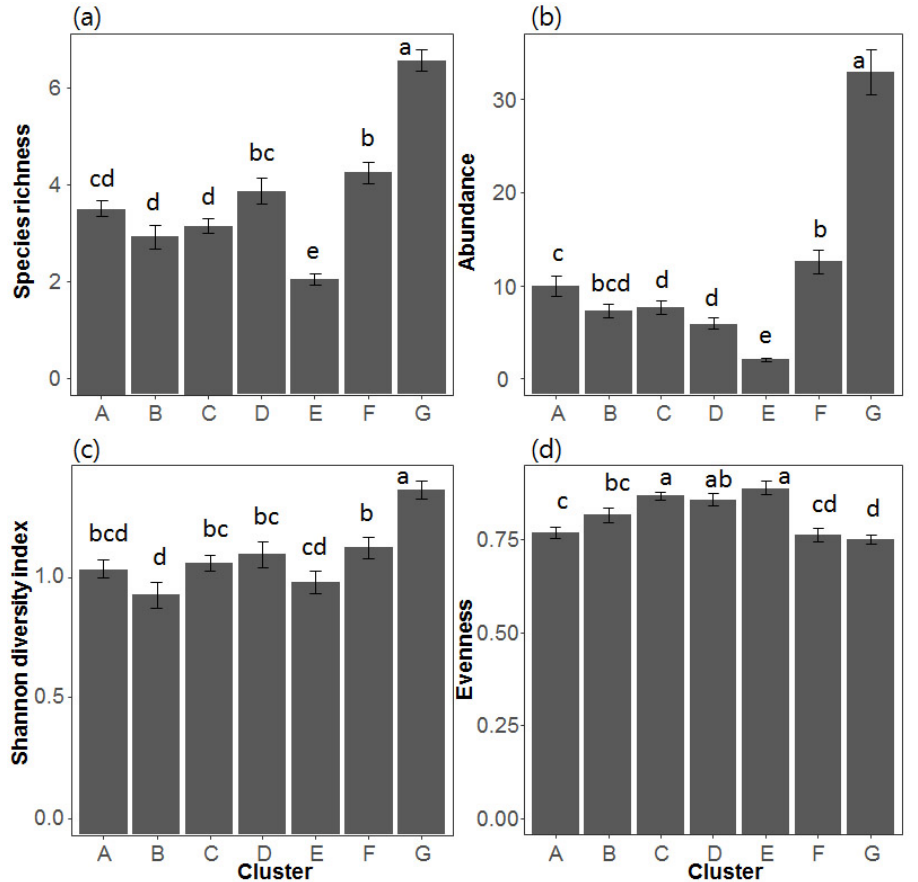
Figure 4. Differences in community indices: ( a ) species richness (number of species); ( b ) abundance (number of individuals); ( c ) Shannon diversity index; and ( d ) evenness. Different letters represent significant differences between clusters based on Dunn’s multiple comparisons test ( p < 0.05). Error bars indicate standard errors.